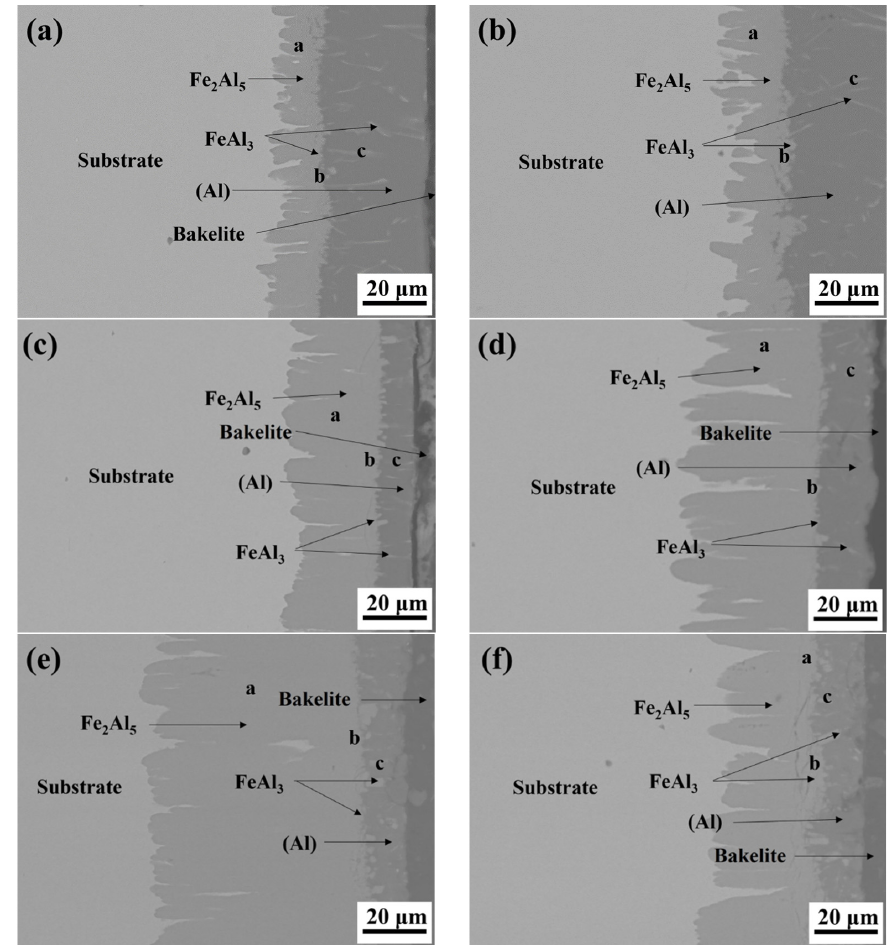
Figure 1. Cross-sectional microstructure of coating of Q345 steel hot-dipped in pure aluminum solution at 700, 750, and 800 ◦ C for 30 s and 3 min, respectively. ( a ) at 700 ◦ C for 30 s, ( b ) at 700 ◦ C for 3 min, ( c ) at 750 ◦ C for 30 s, ( d ) at 750 ◦ C for 3 min, ( e ) at 800 ◦ C for 30 s, ( f ) at 800 ◦ C for 3 min. Table 2. Phase Analysis by EDS in Figure 1